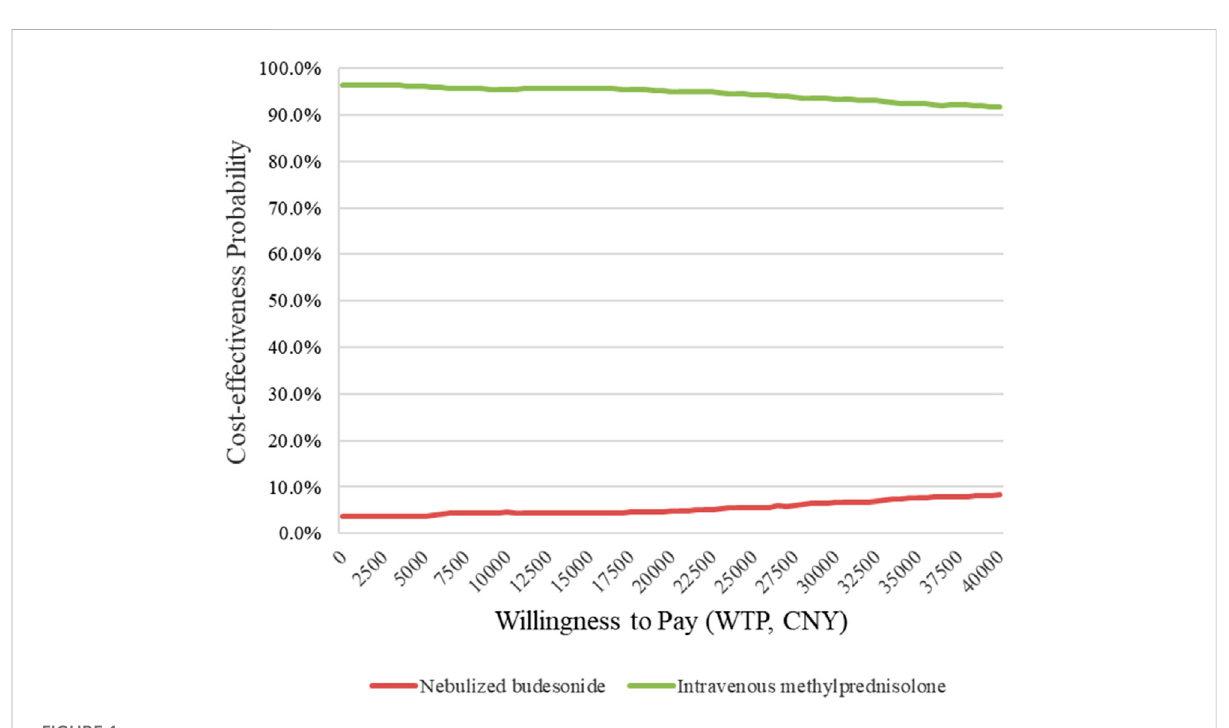
FIGURE 1 CEAC by bootstrap analysis on the clinical ef fi cacy